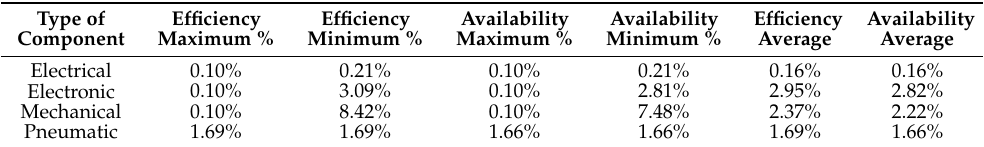
Table 16. Efficiency and availability improvements comparing PPM and IPPM strategies for type of component.